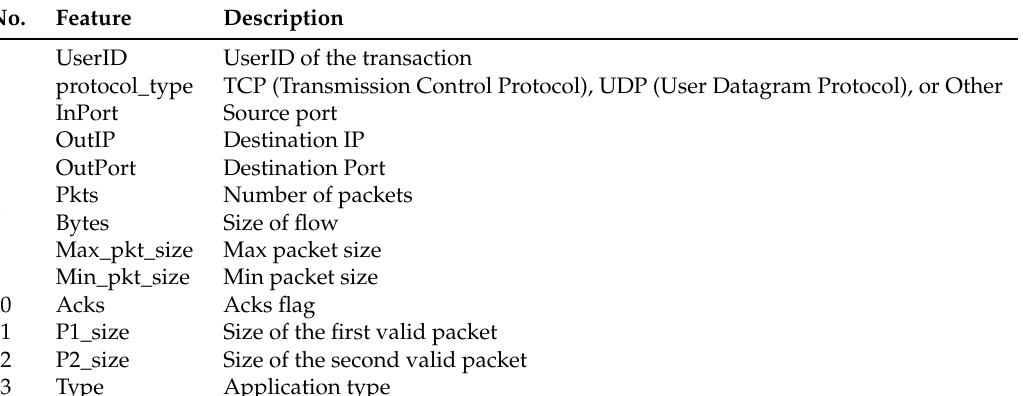
Table 2. Features of transactions on the BUCT dataset.